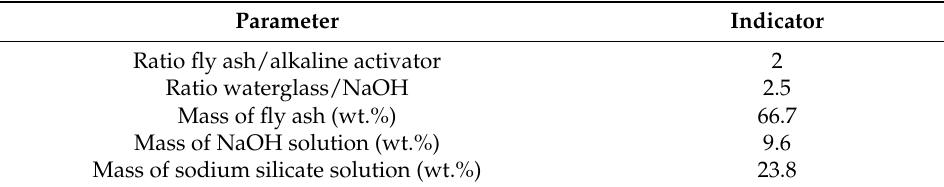
Table 1. Mix design for AAFA paste.